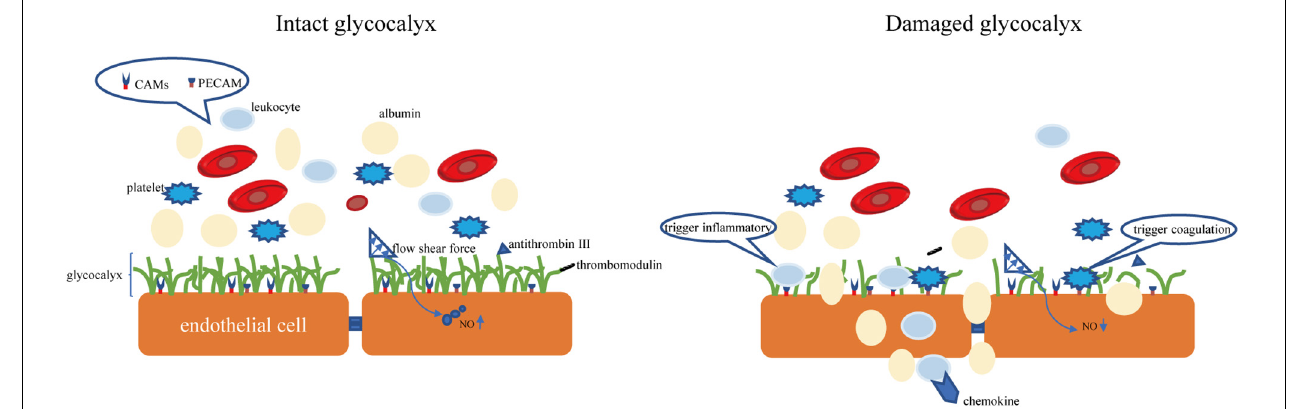
FIGURE 2 | The intact glycocalyx can maintain the permeability of the blood-brain barrier. Damage to the glycocalyx will increase the permeability of the blood-brain barrier (for example, albumin exudation). The CAMs and PECAM hidden in the glycocalyx are exposed due to the shedding of the glycocalyx, causing the aggregation of leukocytes and platelets. CAMs, endothelial cell adhesion molecules. PECAM, platelet/endothelial cell adhesion